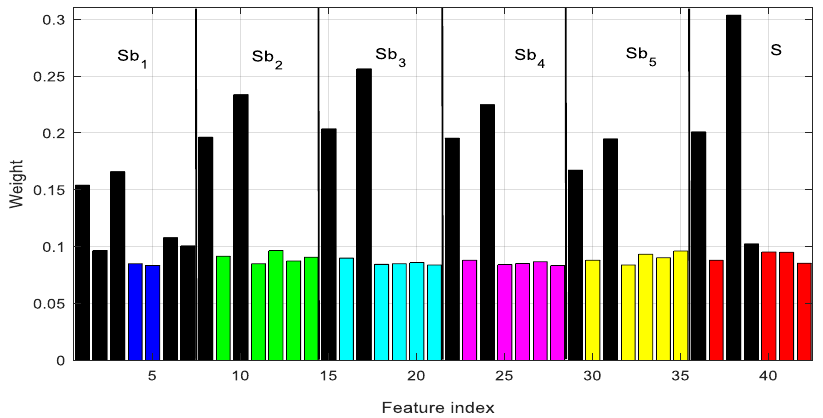
Figure 9. The weight of individual features extracted from different subbands (indicated by different colors). The 16 features are selected (black color) from different subbands according to their weights. Sb 1 …Sb 5 represent five subbands and fullband EEG signal (before subband decomposition) for case D–E.